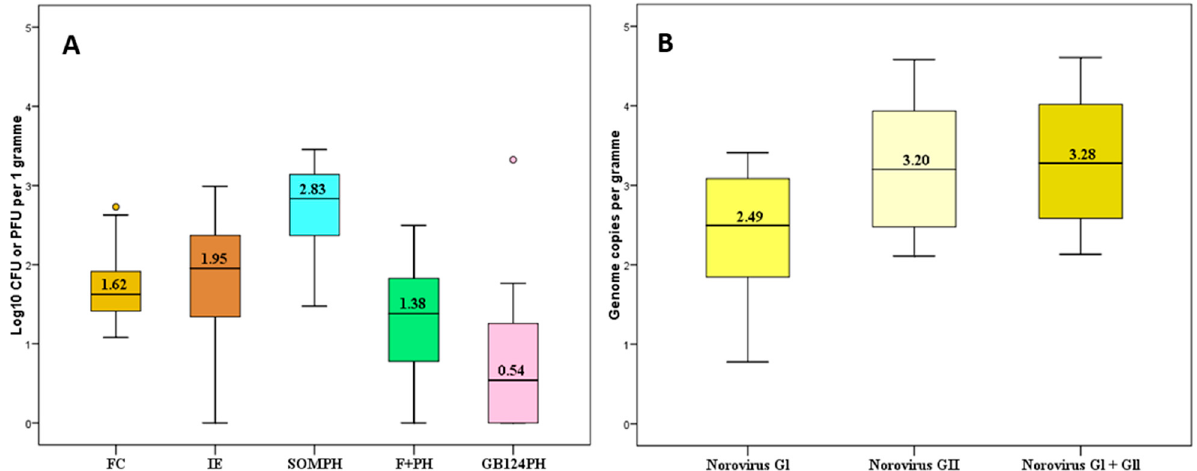
Figure 2. Box plots of faecal indicator ( A ) and NoV ( B ) (genogroups I and II) concentrations in mussel digestive glands ( n = 24). Values beneath the detection limits were assigned a value of zero. Those samples presenting 0 PFU, CFU or genome copies/g were transformed to log10 (+1) PFU, CFU or genome copies/g. (FC: faecal coliforms; IE: intestinal enterococci; SOMPH: somatic coliphages; F + PH: F-specific RNA phages; GB124PH: Bacteroides fragilis GB-124 phages). Coloured circles represent mild outliers